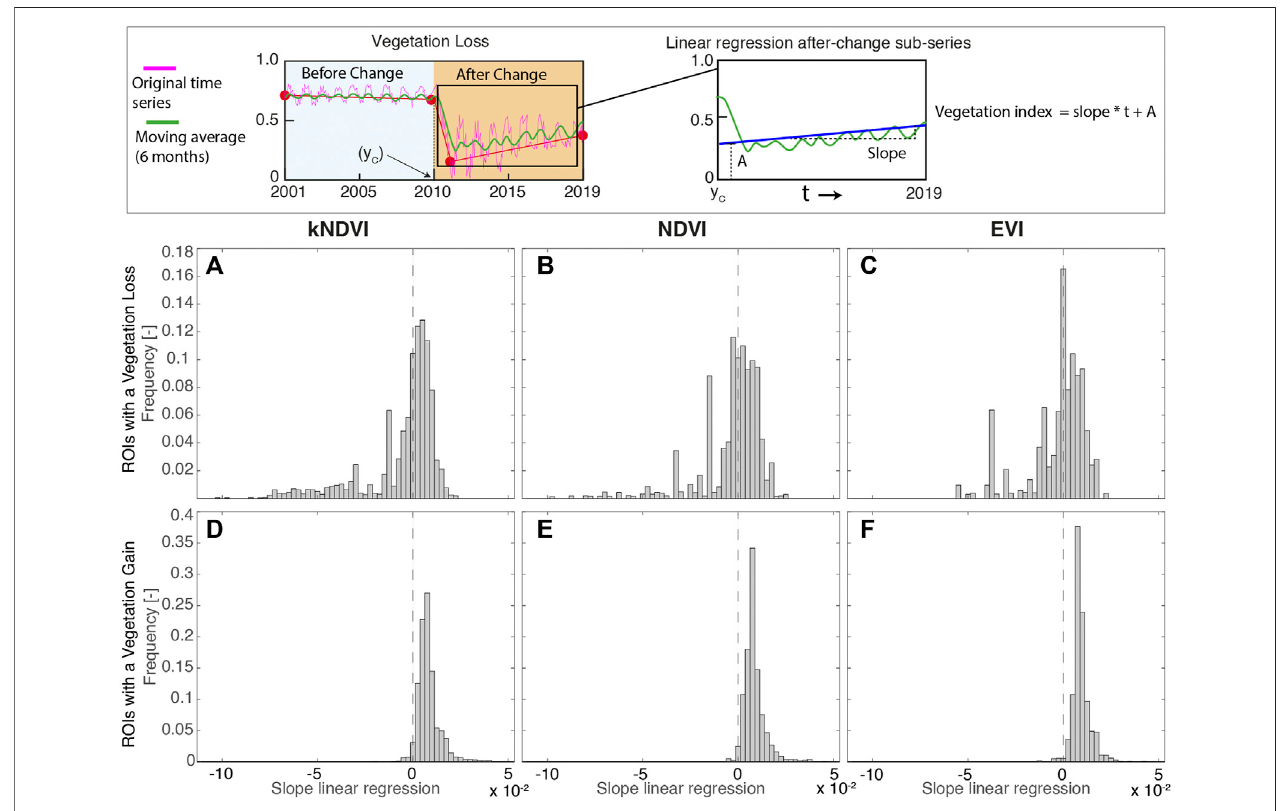
FIGURE7| Distributionofthe(ROI-averaged)slopeofthelinearregressionoftheindextimeserieswithinROIsafteryearofchange.Thetoppanelexplainshowthis quantity has been evaluated for a single pixel. (A) – (C) Forest loss (D) – (F) Forest gain. The vegetation changes are detected through kNDVI ( (A) , (D) ), NDVI ( (B) , (E) ) and EVI( (C) , (F)